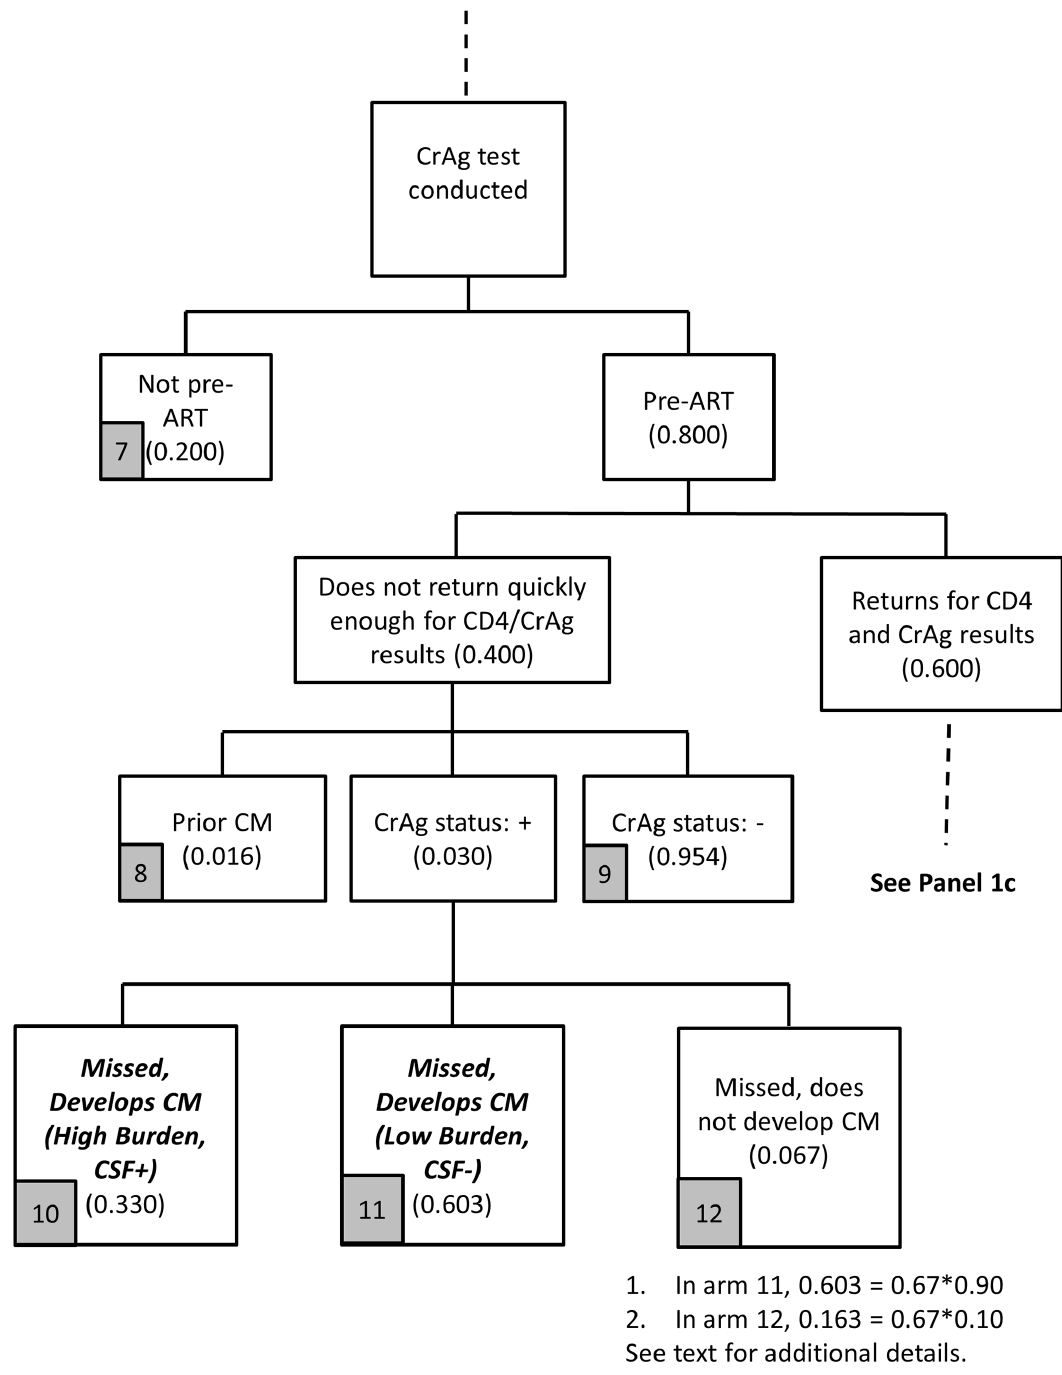
Fig 2. Reflex screening flowchart (Panel 1b).